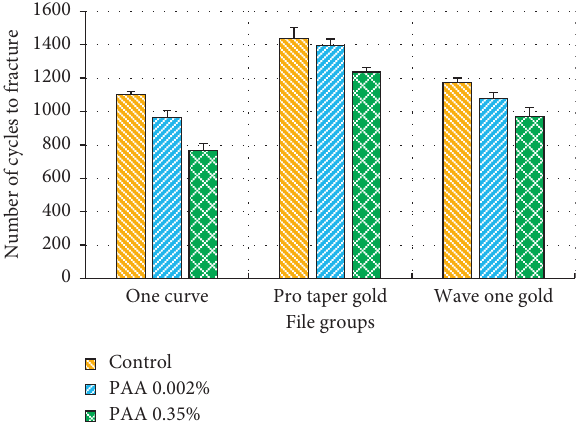
Figure 2: Mean and standard deviation values of cyclic fatigue resistance for the tested file groups.